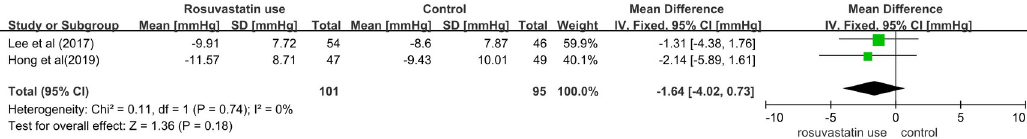
Fig 6. Pooled mean differences for the outcomes of diastolic blood pressure changes in patients with hypertension treated with a combination of rosuvastatin and one antihypertensive agent.